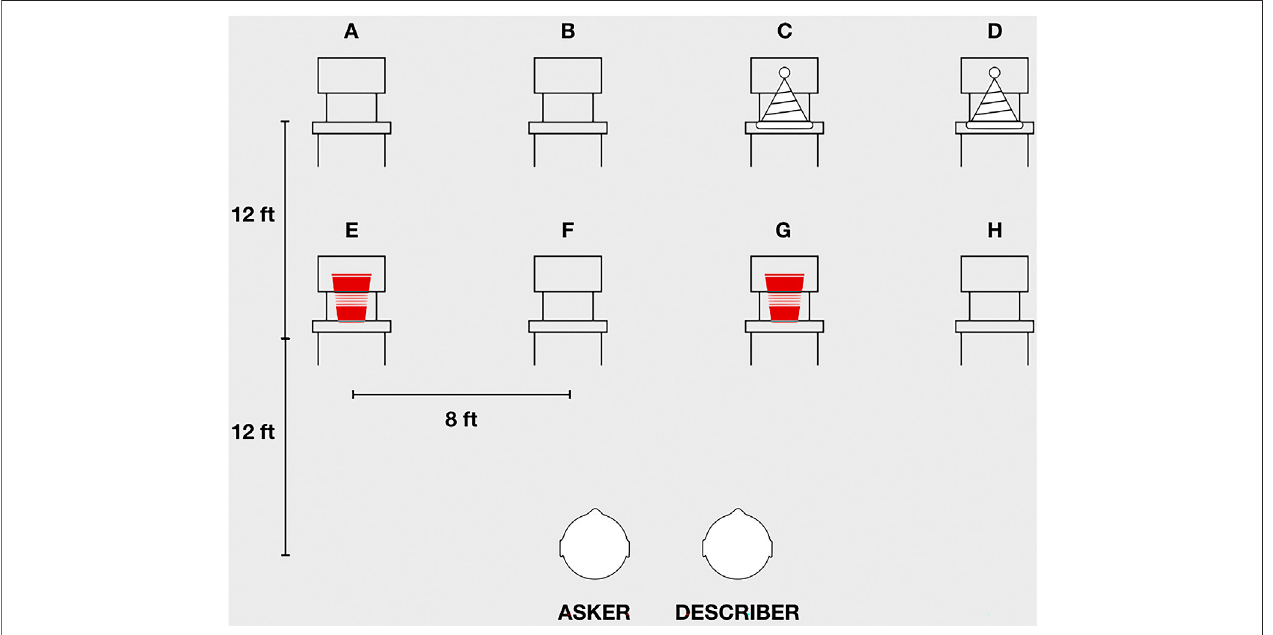
FIGURE 1 | A schematic depiction of the task layout (not to scale). Participants sat before an array of chairs (labeled (A – H) in a large performance space. After watching an actor carry out actions involving two pairs of objects (e.g., hats, cups), the describer answered a series of questions posed by the asker.